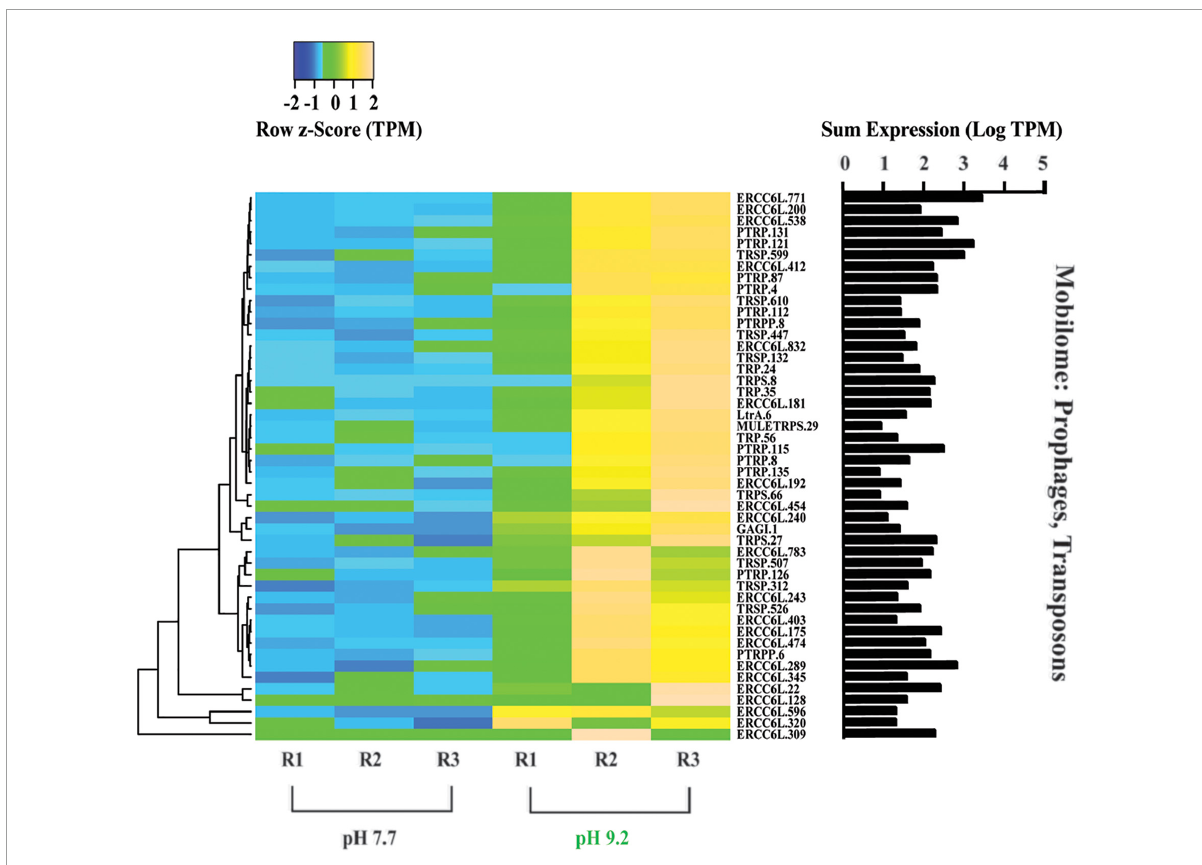
FIGURE6 Heat map depicting differentially expressed genes relating to the “Mobilome: prophages and transposons”. All TPM values were row z-scored, with increases in proportional transcript abundance indicated in yellow, and decreases in proportional transcript abundance indicated in blue. Cladogram clustering is to demonstrate similarity in expression. The sum of transcripts across all treatments (LogTPM) is indicated for each